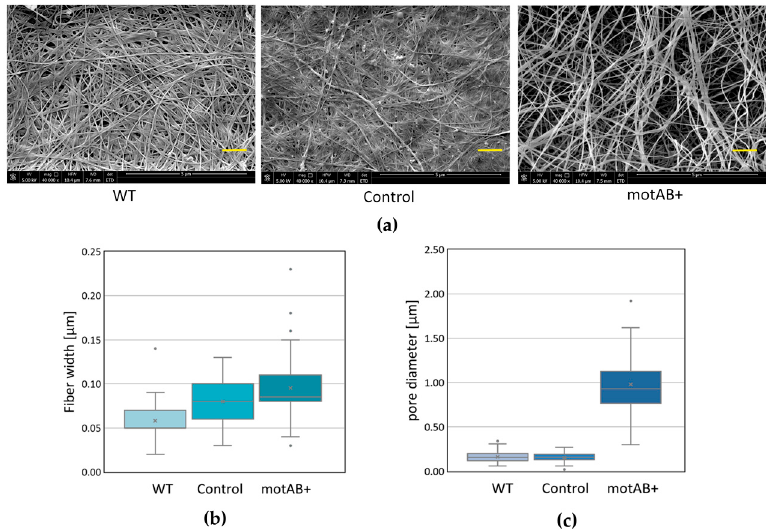
Figure 2. Morphology changes in BNC membranes produced by K. hansenii ATCC 23769 strain variants (WT BNC = wild type strain, Ctrl BNC = strain transformed with pTI99A core vector; motAB+ BNC = mutant transformed with pTI99-motAB vector). ( a ) Representative SEM microphotographs (40,000 × magnification). Yellow scale bars correspond to 1 µ m; Distribution of ( b ) fiber width sizes; ( c ) Distances between fibers measured for 50 sites from three representative microphotographs each.